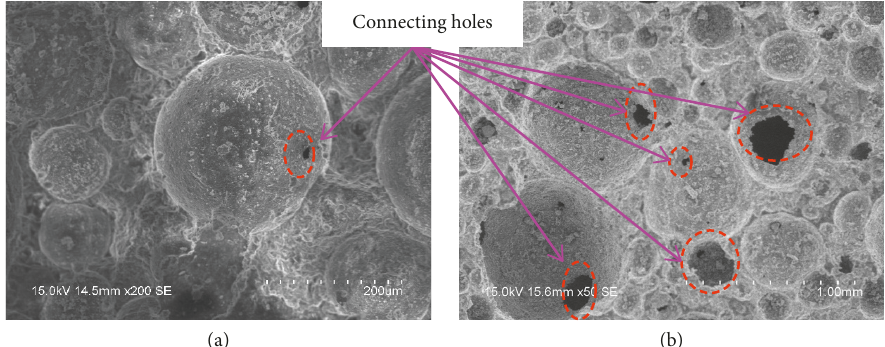
Figure 5: Comparative connecting holes in (a) high and (b) low casting density foamed